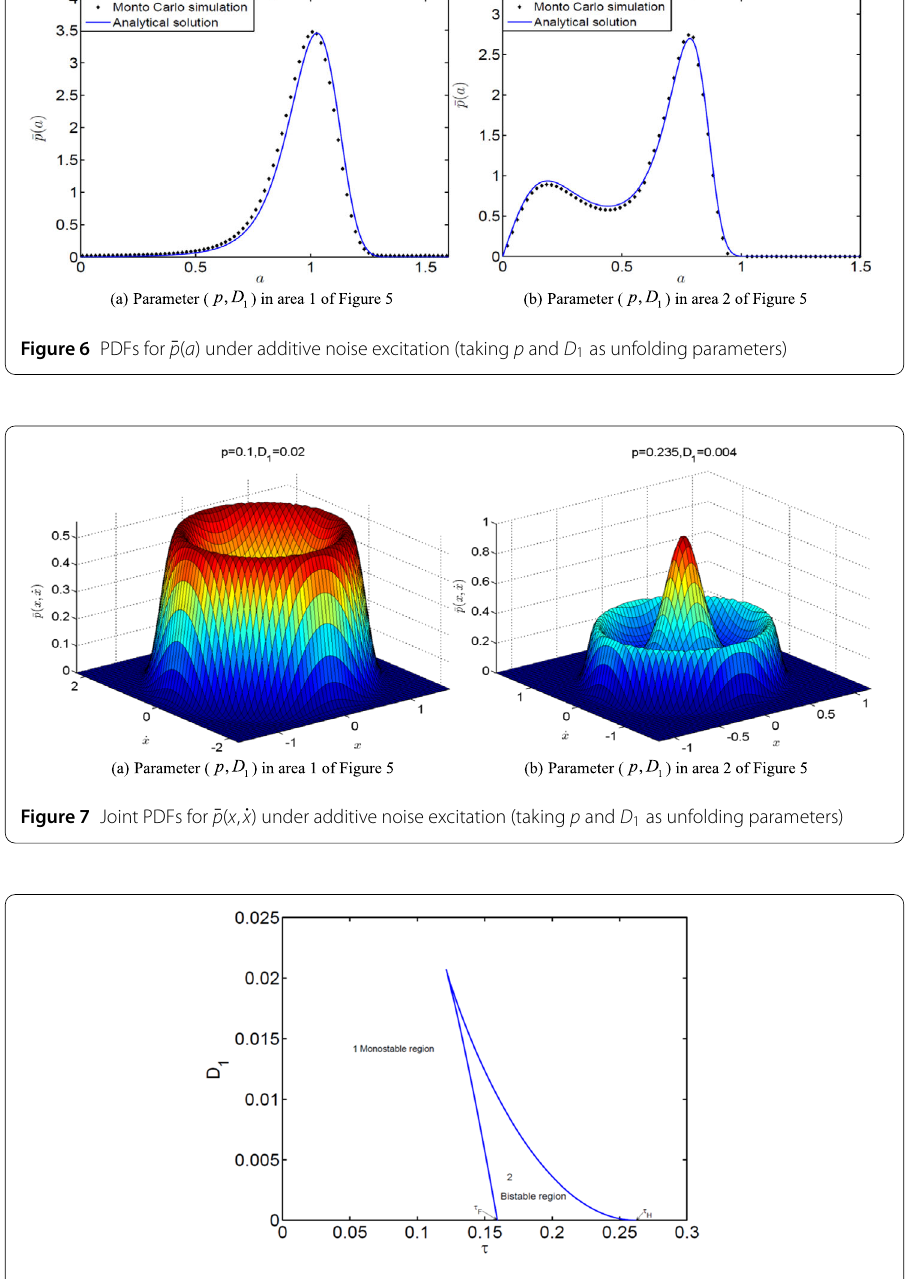
In order to discuss the effects with the variations of parameters τ and D 1 on the stochas- tic P-bifurcation of the system, the stationary PDF ¯ p ( a ) and the joint PDF ¯ p ( x , ˙ x ) are ana- lyzed for a point ( τ , D 1 ) in each sub-area in Fig. 8, then the analytical solutions are com- pared with the Monte Carlo simulation results for original system (3) using the numerical method for fractional derivative [43, 55], and the corresponding results are displayed in Fig. 9 and Fig.